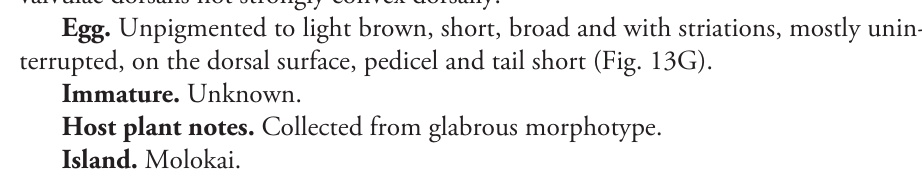
Adult colour. Typically bicoloured, generally pale yellow to green thorax and abdo- men, head darker black or brown, and a dark dorsal stripe extending from head down the thorax. Fore wing membrane slightly fuscous. Adult structure. Fore wing apex bluntly acute; surface spinules dispersed, usually in all cells, but may be limited or absent from cells c+sc and r ; short setae on margins 1 and veins (Fig. 13A). Antennae short (av. length 0.72; ratio AL:HW av. 1.38); genal processes extremely short and bluntly rounded (ratio VL:GP av. 3.27); short setae on vertex and thorax; distal proboscis segment moderately long (av. length 0.11); hind tibia slender, subequal or longer than head width (ratio HW:HT av. 0.95) (Fig. 13B– 1.14), more or less parallel sided before tapering below dorsally flattened apex with bipartite sclerotization; distal aedeagus segment longer or subequal to paramere (ratio PL:AEL av. 0.91) with base angular and slightly inflated, and a large, broadly rounded, hooked apex (ratio AEL:AELH av. 2.30). Female terminalia (Fig. 13H): proctiger moderately long, dorsal surface more or less straight, apex acute, anal ring long (ratio FP:RL 3.41); subgenital plate long (ratio FP:FSP av. 1.48), with no or slight medial bulge ventrally, apex acute; ovipositor apex with reduced serrations (2 above, 2 below), valvulae dorsalis not strongly convex dorsally. Immature.